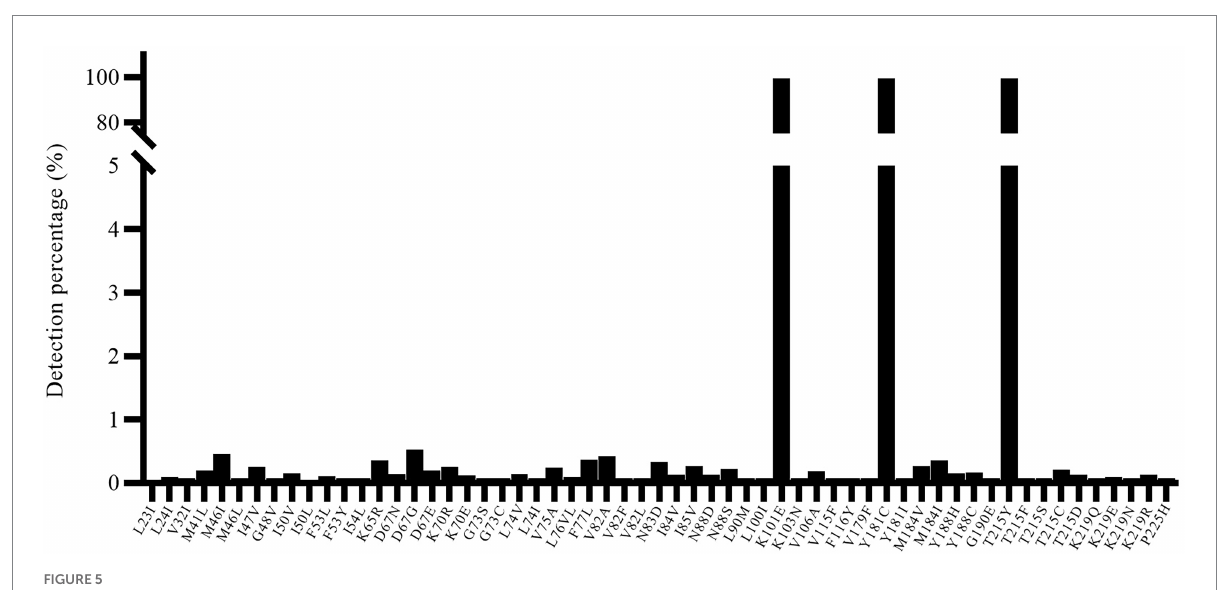
FIGURE 5 The specificity of known resistance mutations and noise value. The HIV-1 NL4-3 with K101E + Y181C + T215Y mutant strain was used for detection, and all three target mutations were detected. At the same time, there were some false positive mutations with a frequency of less than 1% (maybe introduced for PCR amplification).